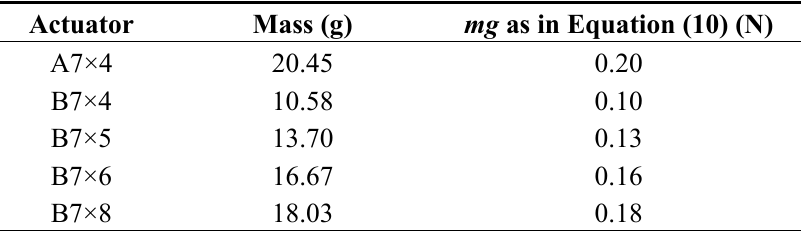
Table 3. Mass of the electroadhesion actuator.